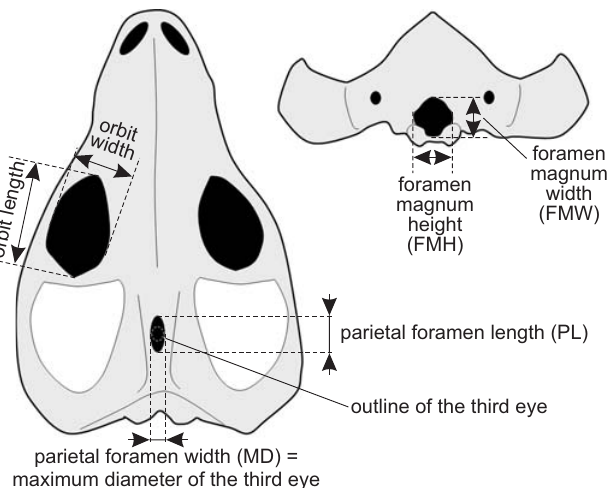
Fig. 1. Measurement protocol of foramen magnum, parietal foramen, and orbit in